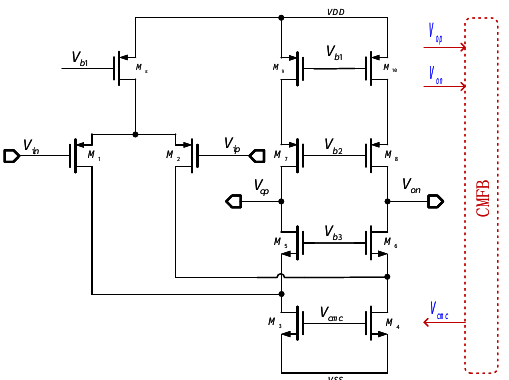
Figure 11. The schematic of fully differential folded-cascade amplifier (CMFB is not